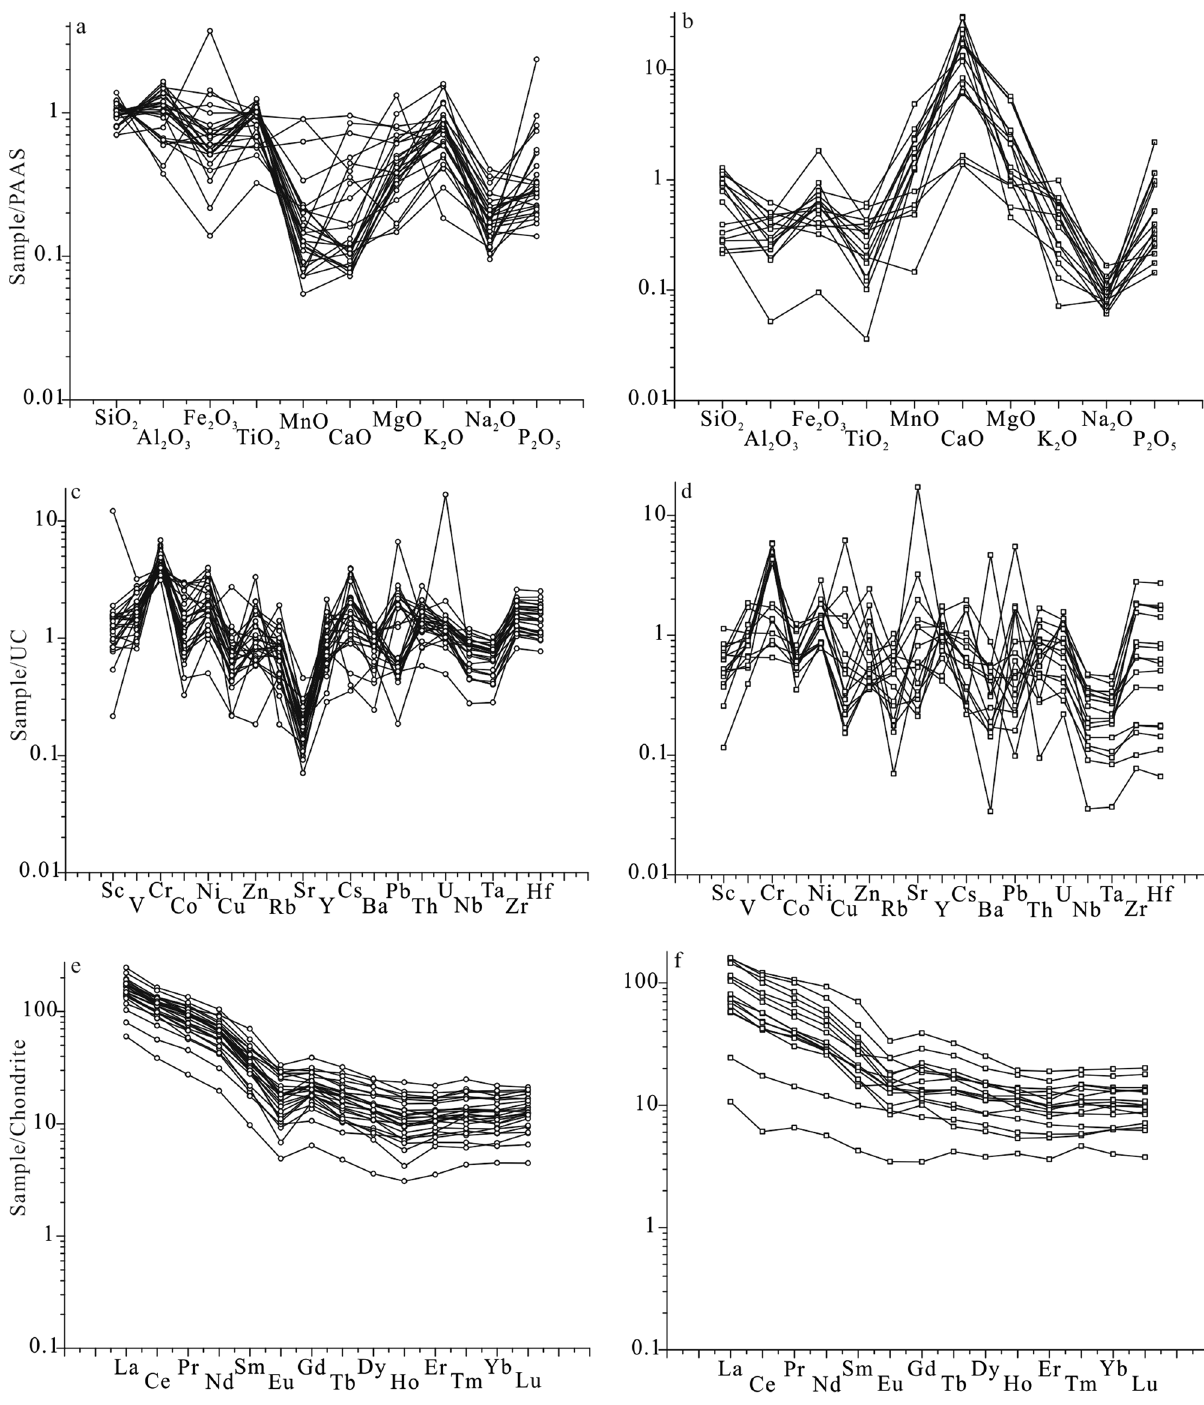
Figure 4. ( a ) PAAS-normalized major element diagram of non-carbonate samples in Well M2; ( b ) PAAS- normalized major-element diagram of carbonate samples in Well M2; ( c ) UC-normalized trace-element diagram of non-carbonate samples in Well M2; ( d ) UC-normalized trace-element diagram of carbonate samples in Well M2; ( e ) Chondrite-normalized rare element diagram of non-carbonate samples in Well M2; ( f ) Chondrite-normalized rare element diagram of carbonate samples in Well M2 (modified after Evensen et al. 22 ) (original data are given in Tables 2, 3 and